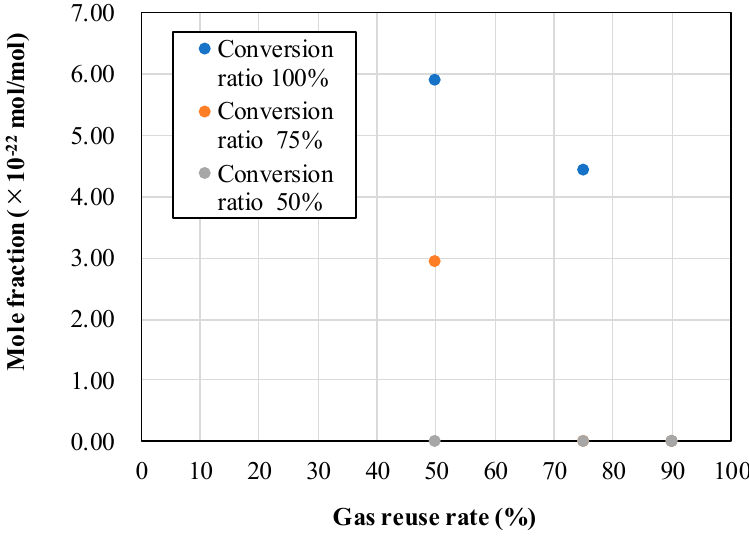
Figure 6. Simulation results of CO concentration for each conversion ratio at “Fin”.